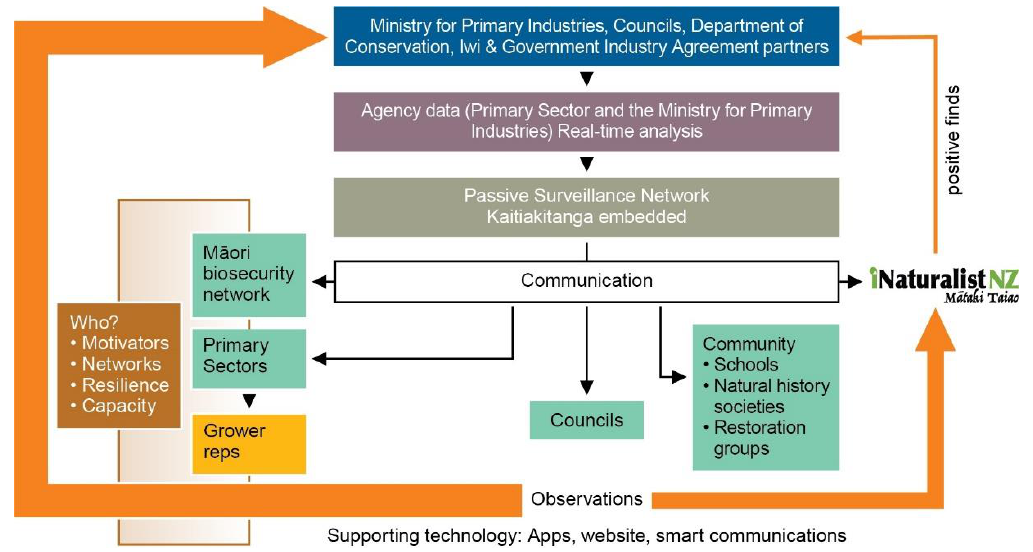
Figure 1. Conceptual model of a potential future general surveillance system circulated for consultation with stakeholders. Ministry for Primary Industries is the central government ministry that includes Biosecurity New Zealand.